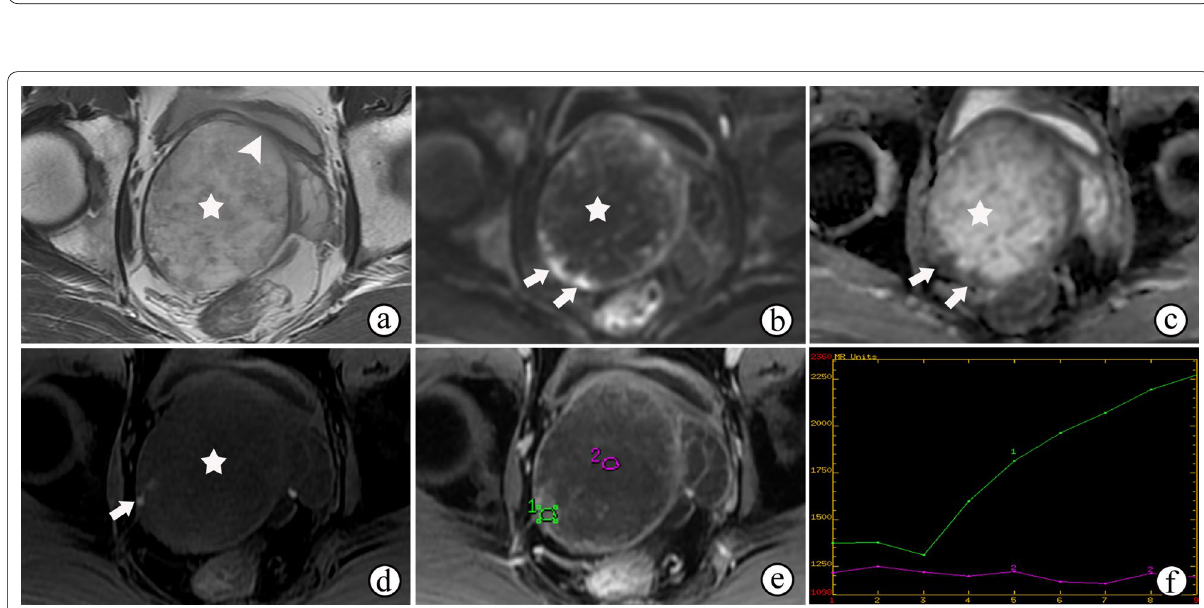
Fig. 11 Prostatic stromal sarcoma in a 41-year-old man with a normal serum PSA level of 0.784 ng/mL. a Axial T2WI shows an oval mass occupying the prostate with heterogeneous hyperintensity, an incomplete hypointense capsule and compressing the bladder (arrowhead). b, c Axial DWI and ADC maps show cystic areas occupying the majority of the mass ( ☆ ), but containing focal solid components with remarkably restricted diffusion (arrow). d Axial fat-suppressed T1WI shows the mass containing a slightly high signal intensity, which suggested a hemorrhagic change (arrow). (e–f) Axial DCE imaging (e) shows that the mass had diffuse but no enhancement of the cystic components ( f, curve 2 ) accompanied by a gradual moderate enhancement restricted to the solid components ( f, curve 1